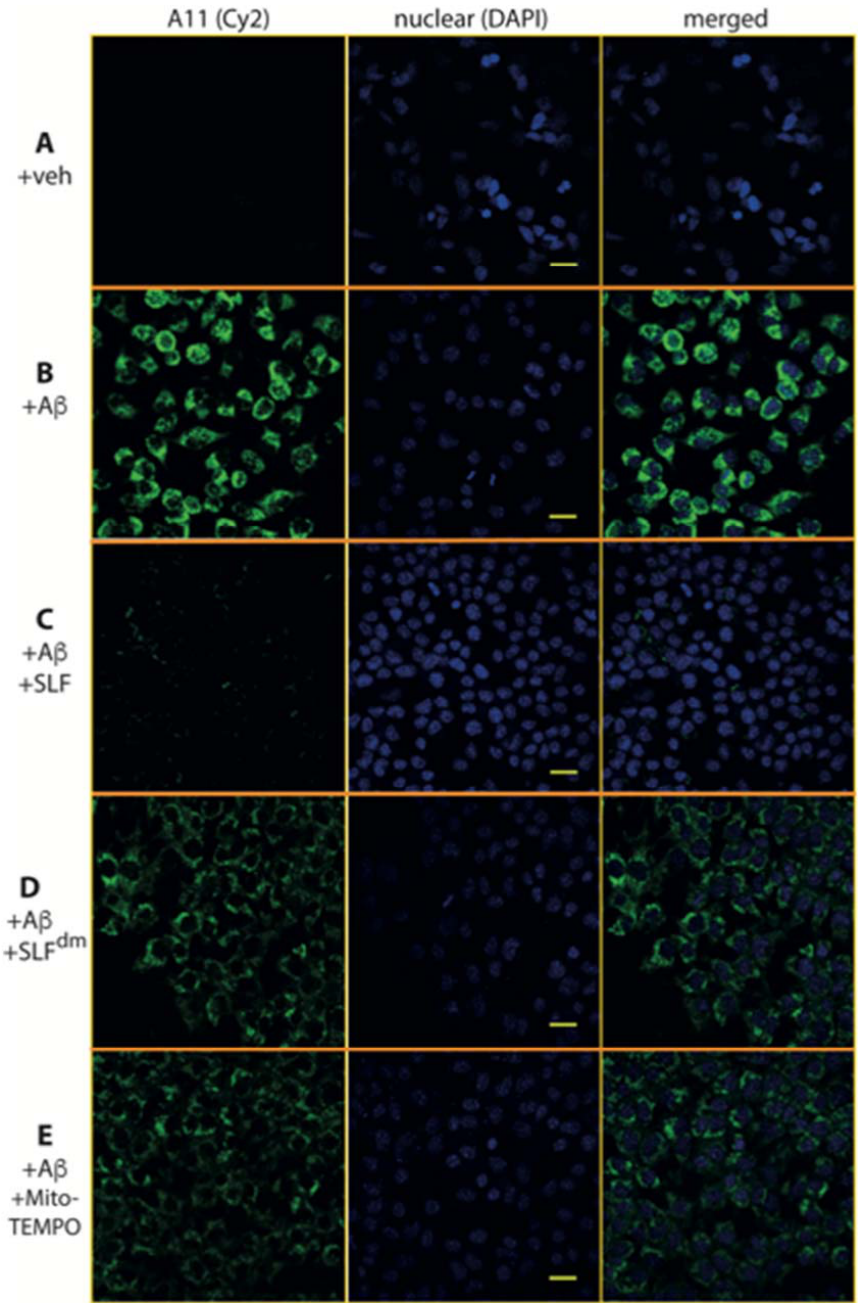
Figure 12. SLF blocks A β O formation of exogenous A β added to cultured N2a neurons. Shown are confocal images of N2a cells stained with the oligomer-specific antibody A11 (green signal). A control with only the DMSO vehicle added (no A β ) is shown in row ( A ). Row ( B ) demonstrates that exogenous A β is readily taken up by neurons and adopts the oligomer-specific conformation. Row ( C ) shows the accumulation of imported A β O is blocked by SLF. The significance of the nitroxyl antioxidant functionality in blocking oligomer formation is demonstrated by the diminished ability of SLF dm to inhibit intracellular A β O accumulation (row D ). Similarly, the antioxidant activity of MitoTEMPO lowers A β O accumulation (row E ), but not as effectively as the A β -targeted SLF compound. The left column is the Cy2 stain, the middle column is the DAPI nuclear stain, and the right column is the merging of the first two columns. Scale bar represents 20 µ